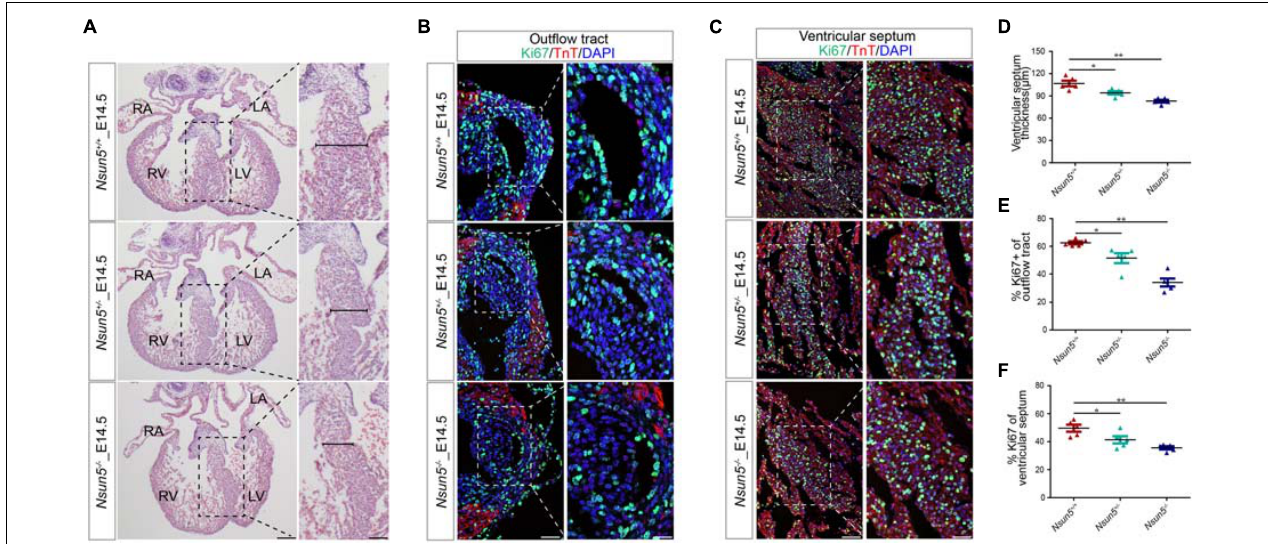
FIGURE 3 | The Nsun5 deletion reduces cell proliferation. (A,D) H&E stained sections from E14.5 hearts indicated a thinner ventricular septum resulting from Nsun5 deletion. n = 5/group. (B,E) Quantitative results showed reduced proliferation in Nsun5 deletion OFT aorta area by immunofluorescence staining. The data was presented as the ratio of Ki67 + cells/total OFT aorta area cells. Cardiomyocytes were labeled by TnT. n = 5/group. (C,F) Quantitative results showed reduced proliferation in Nsun5 deletion ventricular septum by immunofluorescence staining. The data was presented as the ratio of Ki67 + cells/total ventricular septum cells. n = 5/group. Scale bar = 50 or 25 µ m. All the data were the mean ± SEMs of three dependent experiments. One-way ANOVA test used for statistical calculation. *P < 0.05, **P < 0.01.